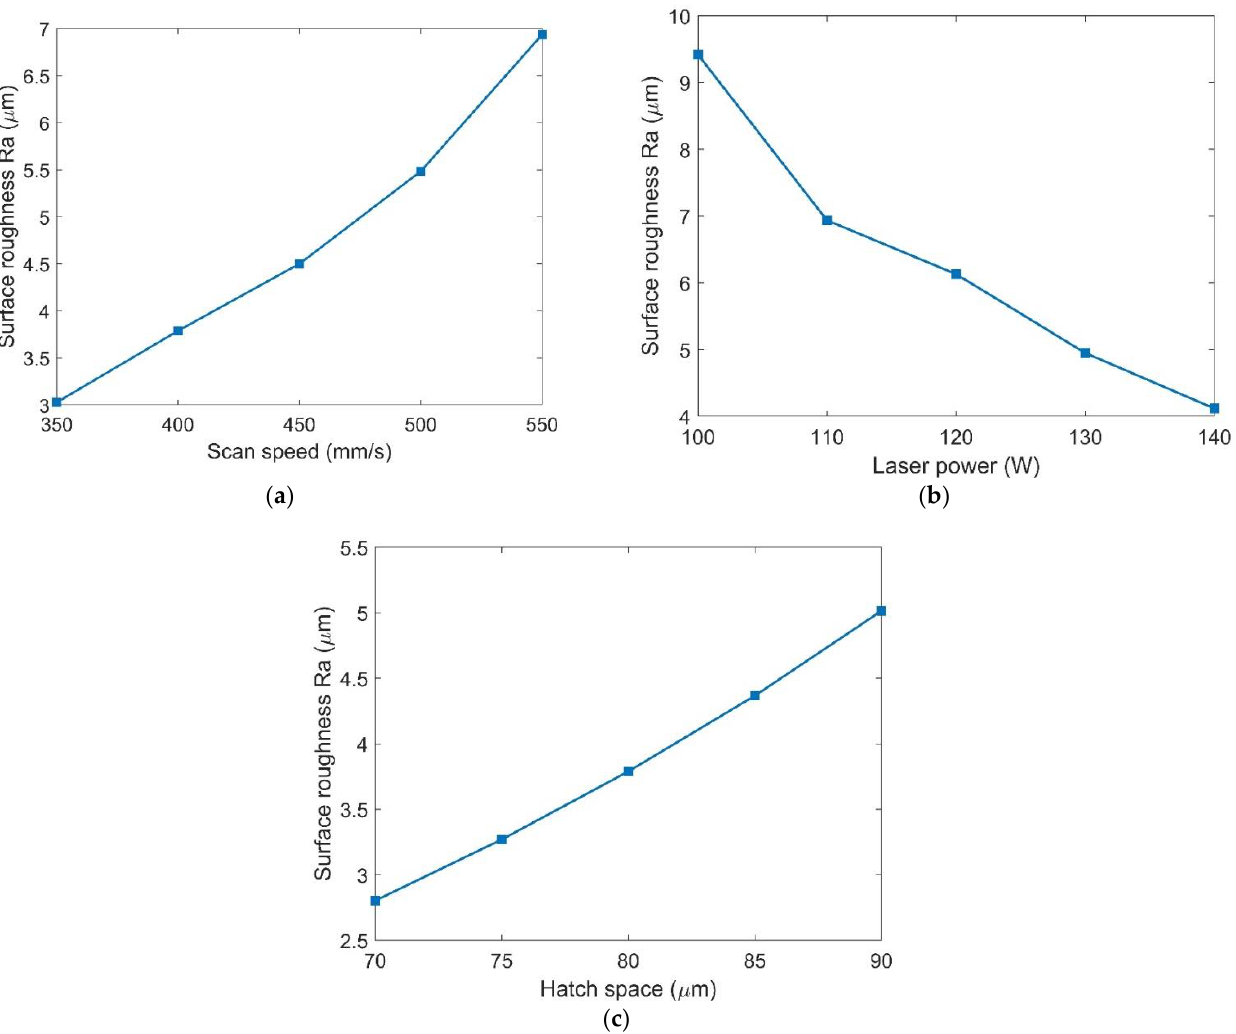
Figure 5. Sensitivity analyses. ( a ) Sensitivity to scan speed. Laser power is 150 W. Hatch space is 80 µm. ( b ) Sensitivity to laser power. Scan speed is 400 mm/s. Hatch space is 80 µm. ( c ) Sensitivity to hatch space. Laser power is 150 W. Scan speed is 400 mm/s. Layer thickness is 35 µm for all sensitivity analyses.